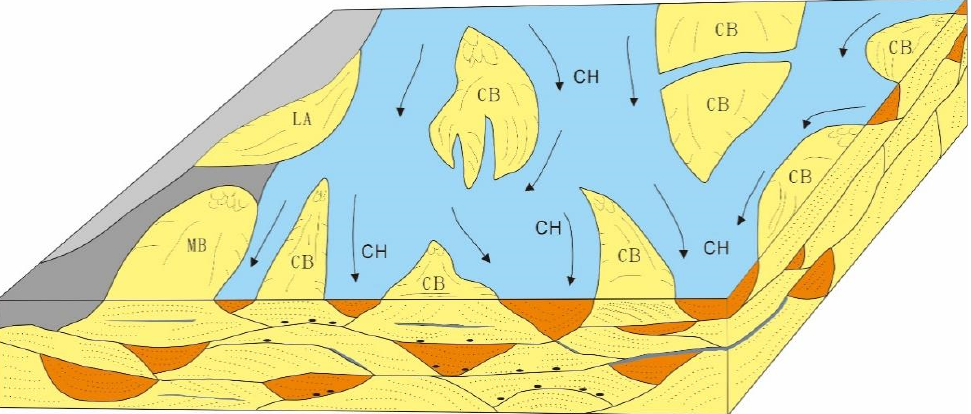
Figure 14. The three periods of the sedimentary model of the Yungang Formation in the Datong Basin outcrops area.